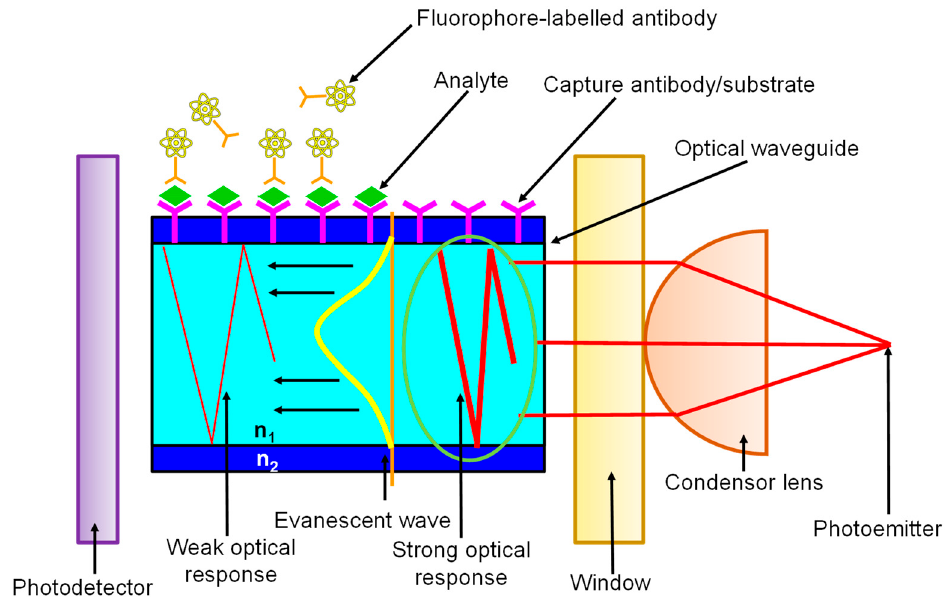
Figure 7. A schematic illustration of evanescent wave-based sensing ( n 2 < n 1 ).